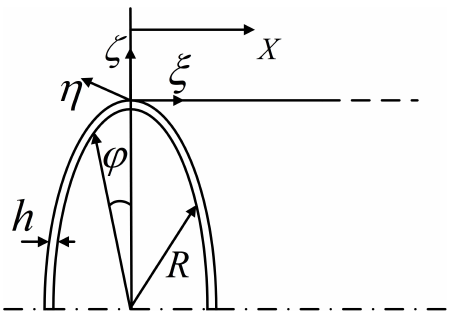
Figure 8. Cylindrical coordinate system: ω , ξ , and η are radial, circumferential, and axial displacements, respectively.